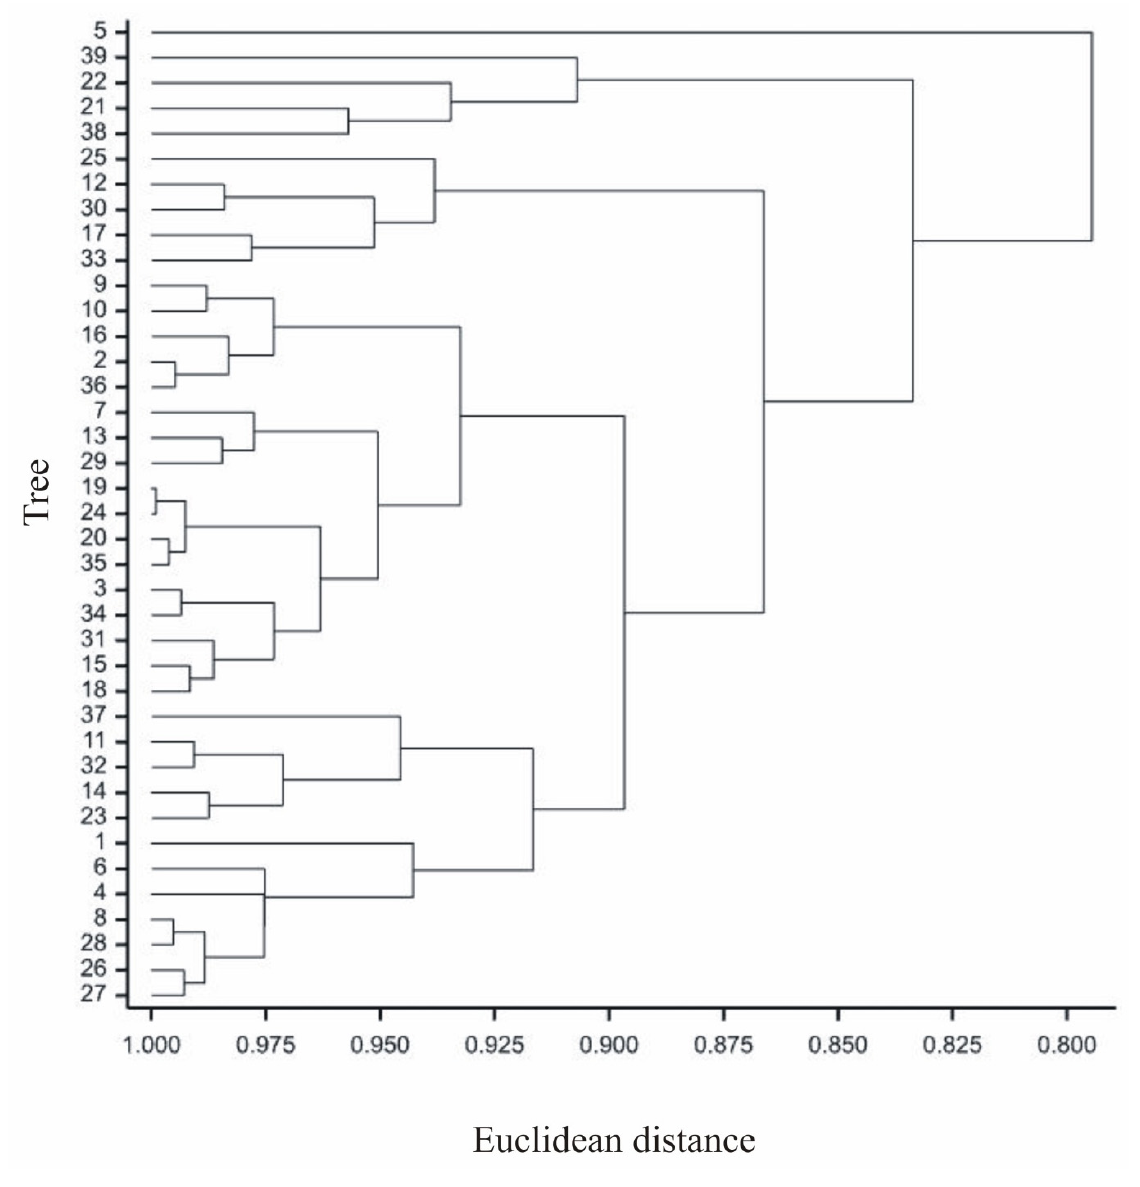
Figure 8. Dendrogram of cluster groupings of 39 P. serotina trees based on all seven quantitative features.